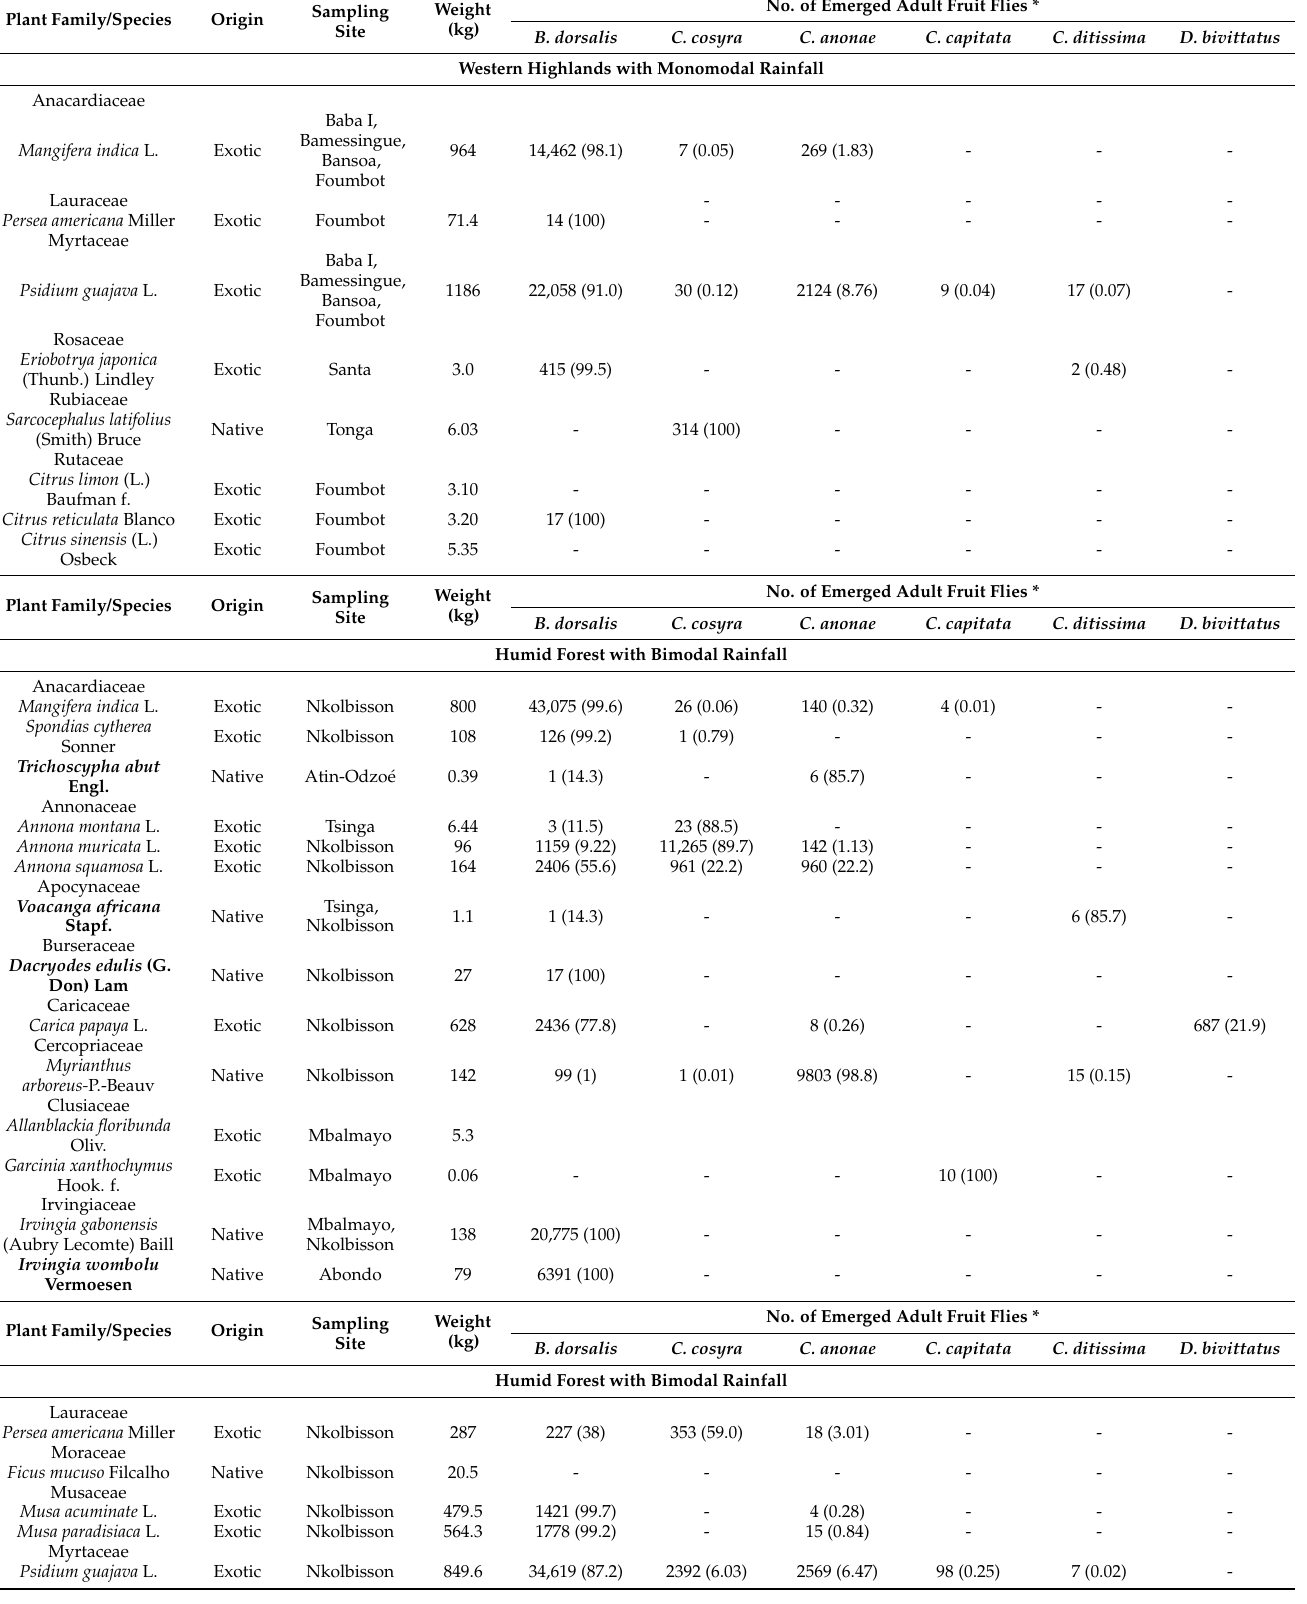
Table 7. Host fruits species sampled from 2011 to 2015 and abundance of fruit fly species that emerged across two agro-ecological zones of